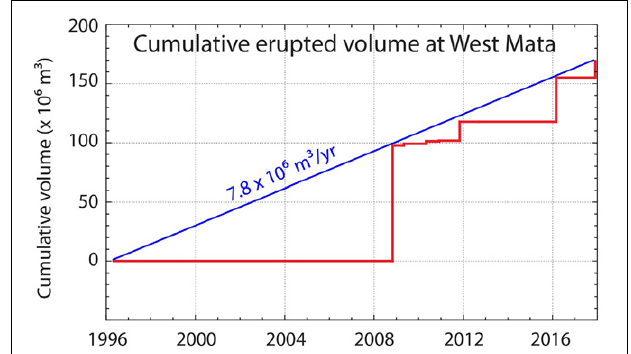
FIGURE 16 | Cumulative erupted volume at West Mata vs. time, based on volumes of depth change between nine repeated ship-based bathymetric surveys listed in Table 1 . Volumes are from Table 2 and Embley et al. (2014) and are plotted at the time they were discovered (the second of each pair of surveys). Trend is remarkably linear and implies volume-predictable eruptive behavior in which the volume of the next eruption is predictable from the time since the previous